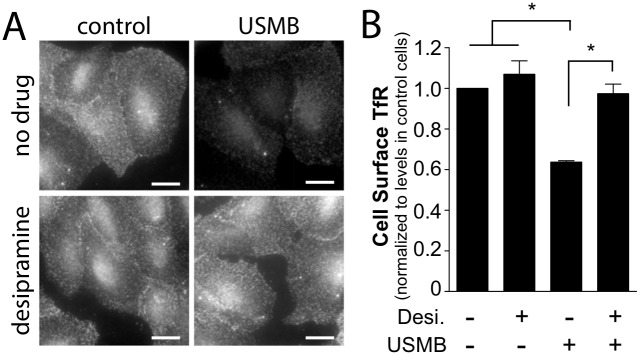
Desipramine treatment impairs the reduction in cell surface TfR levels by USMB treatment.RPE cells grown on glass coverslips were treated with 50 μM desipramine for 60 min, or not treated with this inhibitor (vehicle control). Cells were subsequently treated with USMB or left untreated (control) as indicated. 5 min following USMB treatment, cells were immediately placed on ice to arrest membrane traffic and subjected to immunofluorescence staining to detect cell surface TfR levels. Shown in (A) are representative epifluorescence micrographs of cell surface TfR levels and in (B) the mean ± SEM of cell surface TfR fluorescence intensity in each condition (n = 3 independent experiment, each experiment >20 cells per condition). Scale = 20 μm. *, p < 0.05.